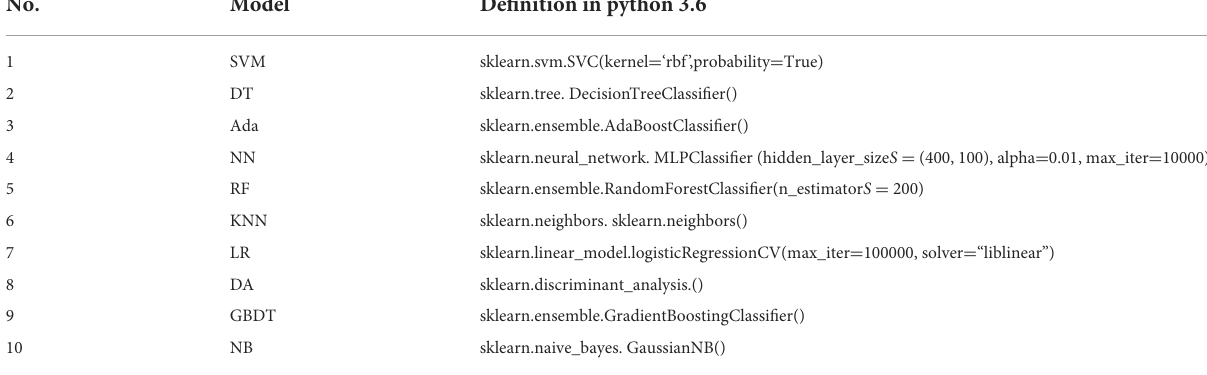
TABLE 3 Descriptions of 10 models in this study.